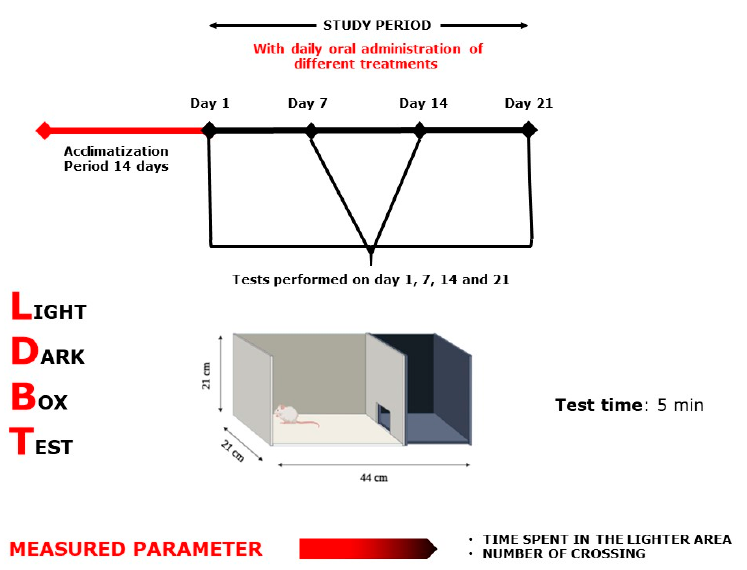
Figure 11. Open Field Test scheme.